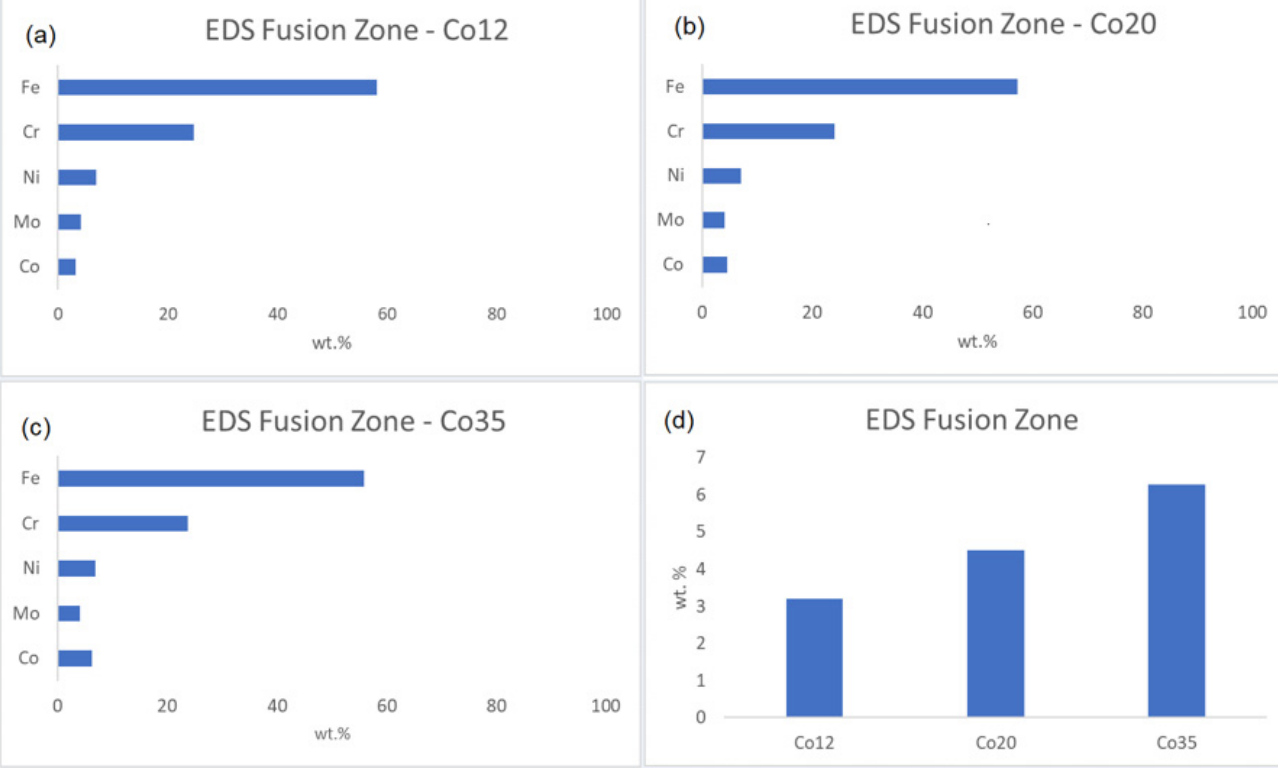
Figure 5. Fusion zone composition for ( a ) Co12, ( b ) Co20, ( c ) Co35 and ( d ) Co wt.% increase for all the conditions.